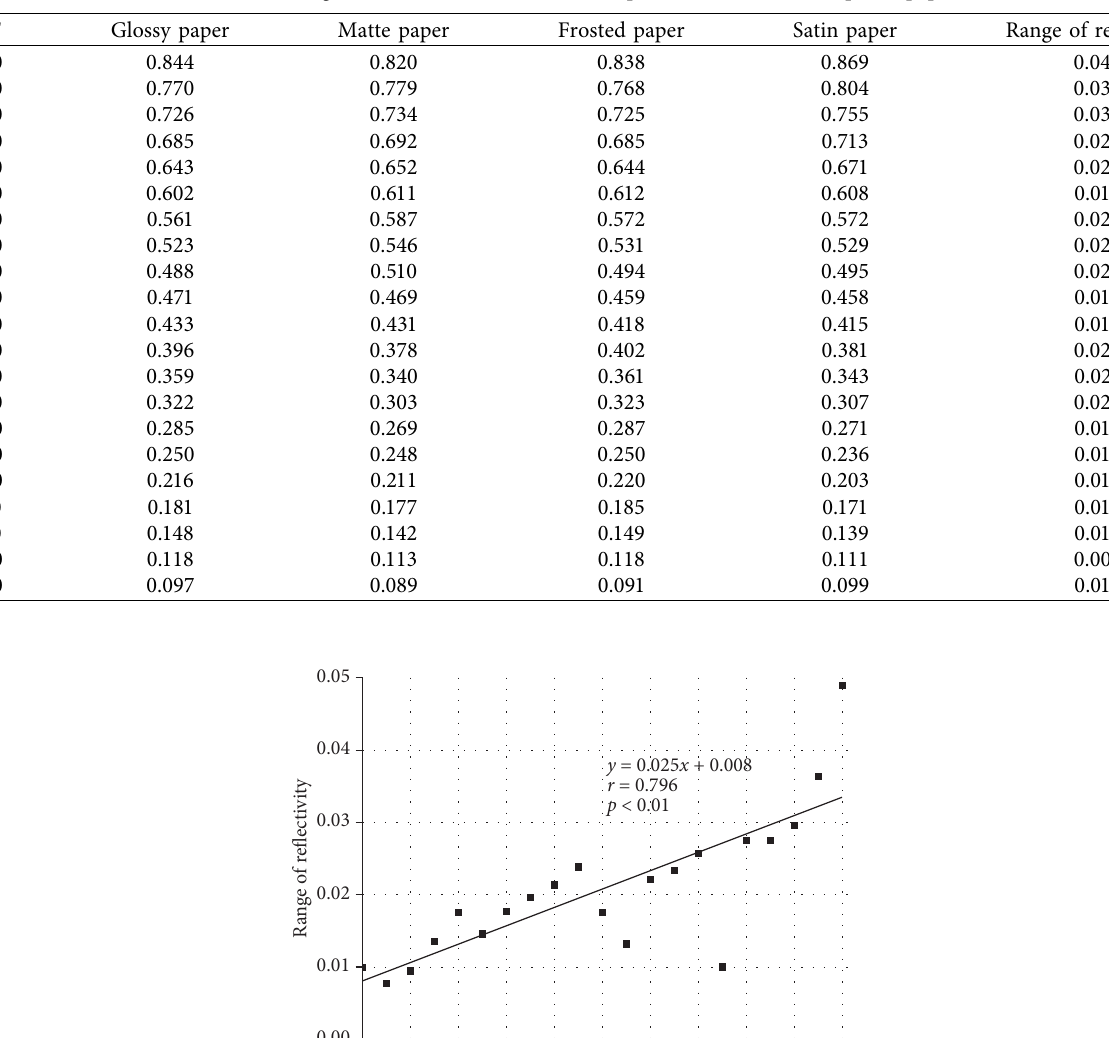
Table 1: Average reflectance statistics of mixed pixels on four kinds of photo paper.